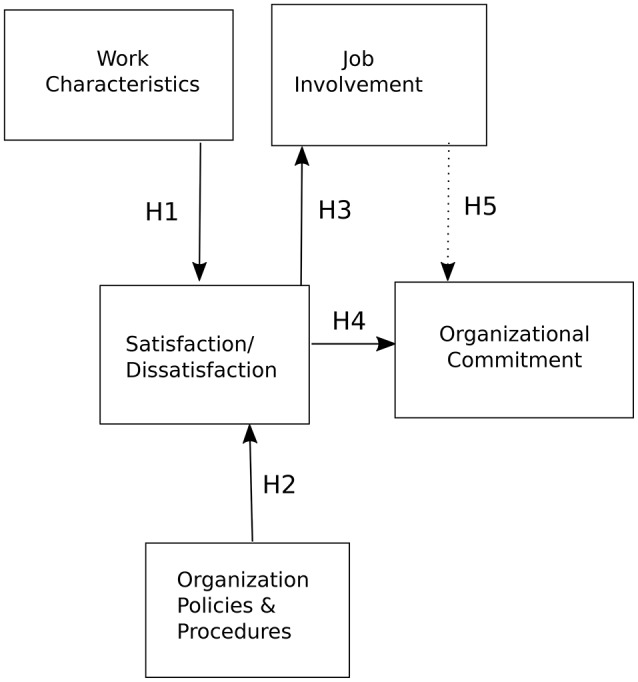
The research model.